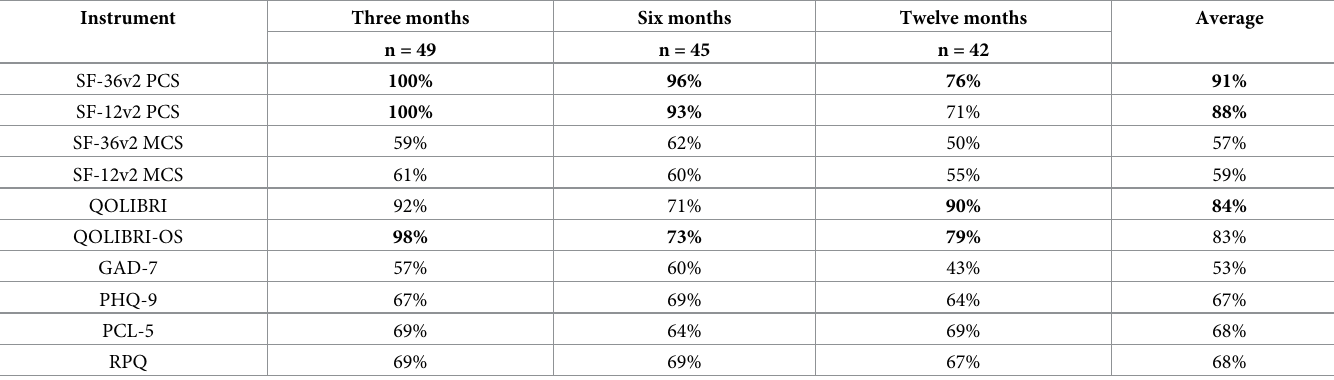
Note. n = number of pairwise comparisons, % = percentage, average = average relative frequencies from 3 to 12 months. Bold values indicate the top three instruments with the highest sensitivity in most group